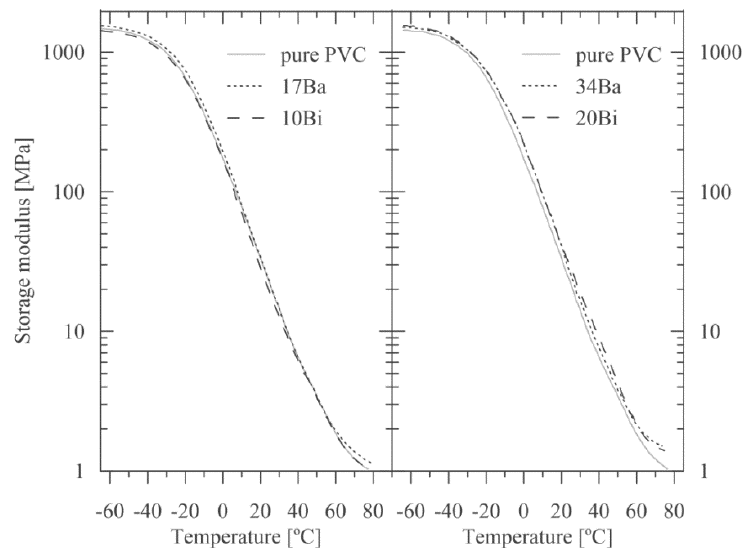
( b ) Figure 6. SEM details of the cross-sections of BaSO 4 /PVC ( a ) and BiOCl/PVC ( b ) samples. 3.3. Impact of Radiopaque Fillers on Thermo-Mechanical Properties Addition of the radiopaque filler into a polymeric matrix also contributes to the re- sulting thermo-mechanical properties of the compounds. Since mineral filler has a sub- stantially higher modulus than polymers, its addition usually reflects in a higher modu-